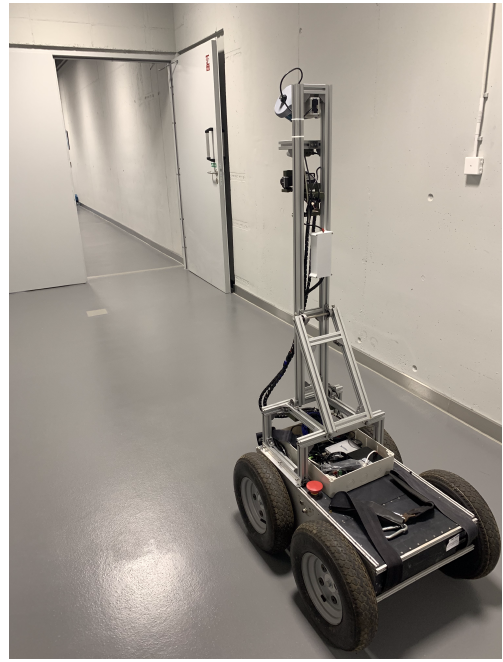
Figure 8. Robot during the measurements.